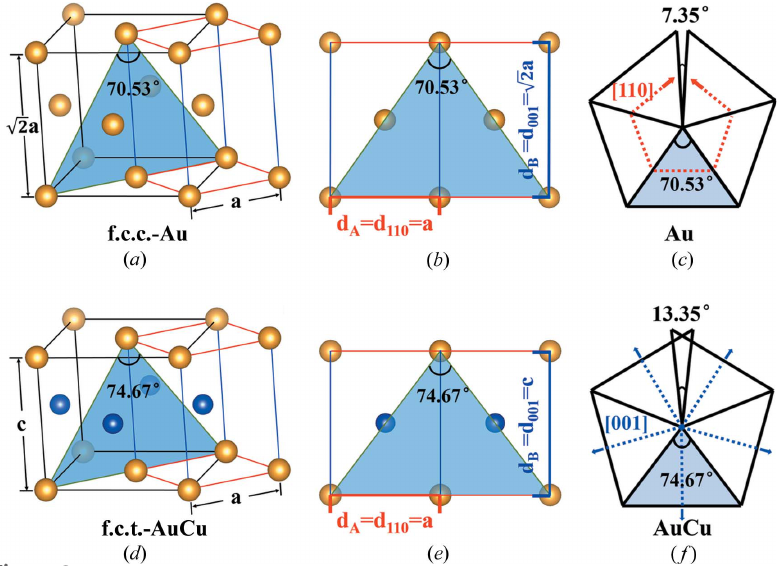
Figure 3 Space imperfection in different decahedral MTPs. ( a ) A unit cell of Au single crystal with f.c.c. structure. A b.c.t. repeating unit can be extracted from the f.c.c. structure. ( b ) Structural projection with a blue triangle which corresponds with a segment of decahedral MTPs. ( c ) Diagram of Au decahedral MTP comprising a gap of 7.35 (cid:3) . The blue triangles with 70.53 (cid:3) angles of the top three images have a one to one correspondence. The main expansion direction [110] has been marked with red broken lines. ( d ) A unit cell of an AuCu single crystal with an f.c.t. structure. A b.c.t. repeating unit can be extracted from the f.c.t. structure. ( e ) Structural projection with a blue triangle that corresponds with a segment of intermetallic decahedral MTPs. ( f ) Diagram of AuCu decahedral MTP comprising an overlap of 13.35 (cid:3) . The blue triangles with 74.67 (cid:3) angles of the bottom three images have a one to one correspondence. The main expansion direction [001] has been marked with blue broken